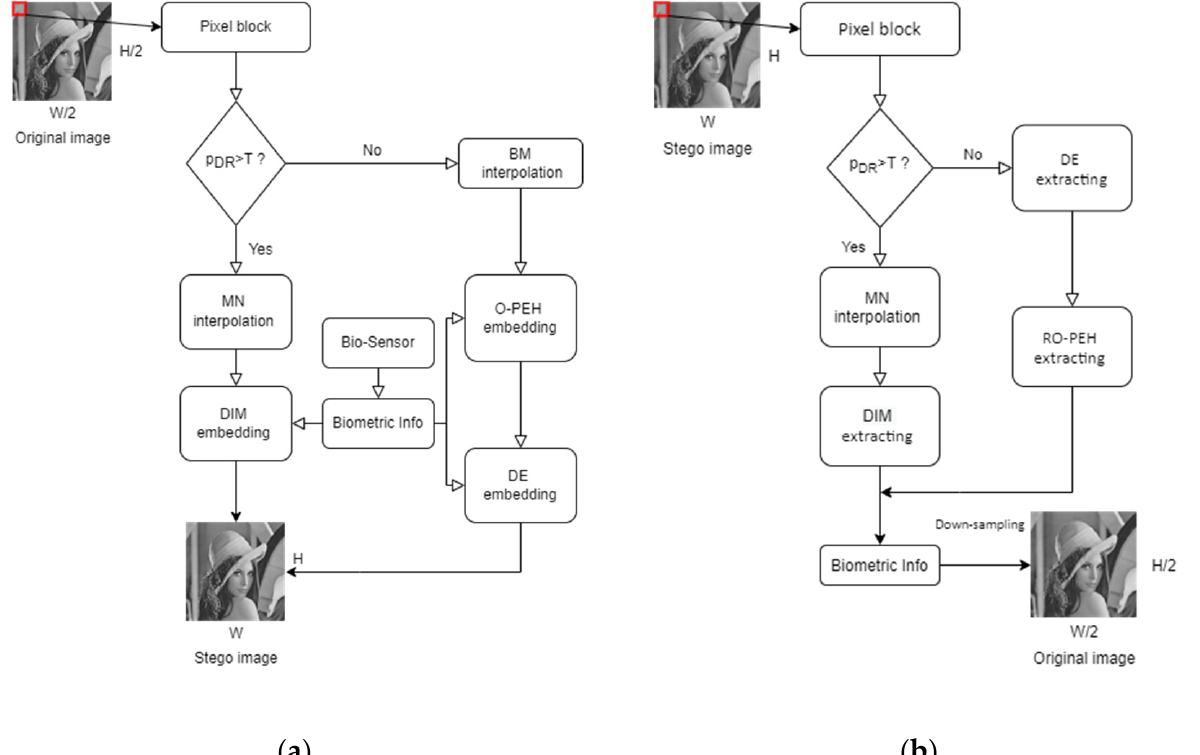
ℂ(ℊ: ℊ + 2, 𝒽: 𝒽 + 2) . The data embedding process for complex blocks is given in Algorithm 2. Algorithm 2 Data Embedding for Complex Blocks